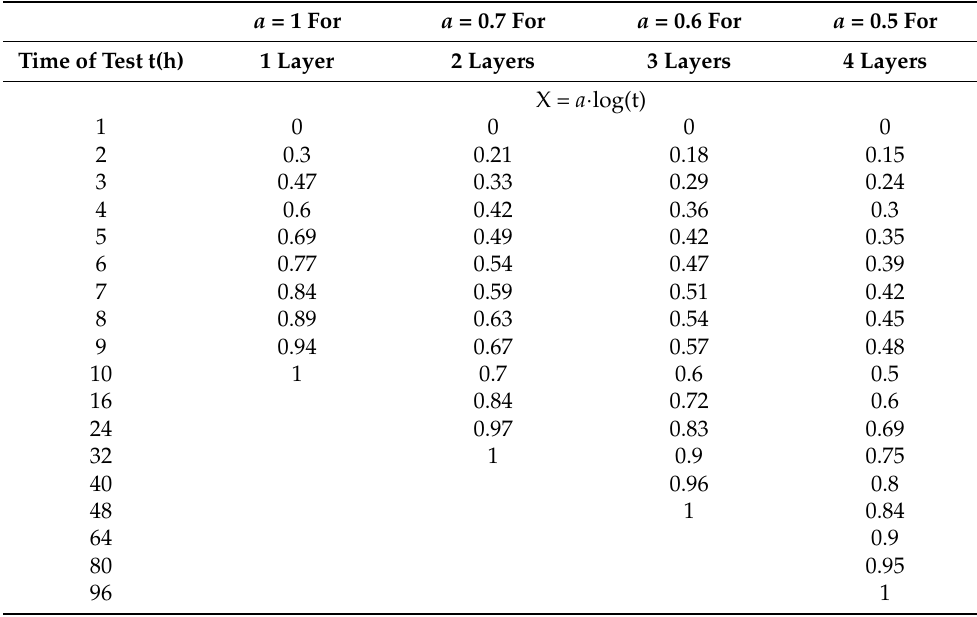
Table 10. Illustrative values of the X coefficient of the C ( t ) model (17) as a function of time and the number of layers of the heated floor